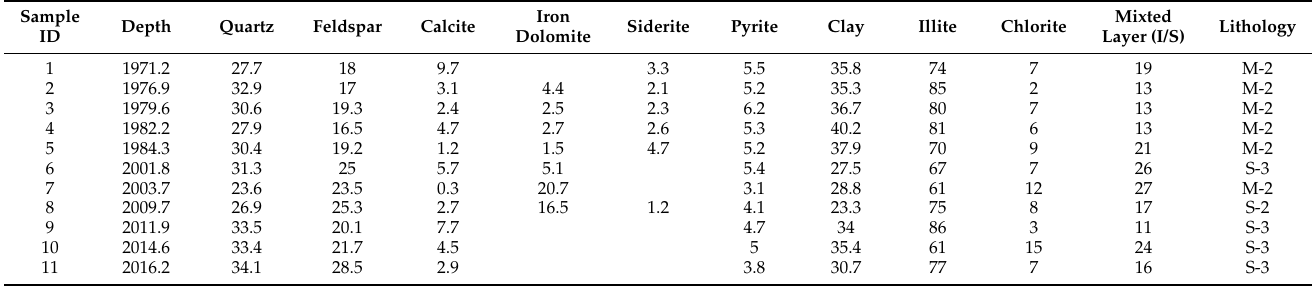
Table 1. Mineralogical compositions and lithofacies of Qingshankou Formation shales.